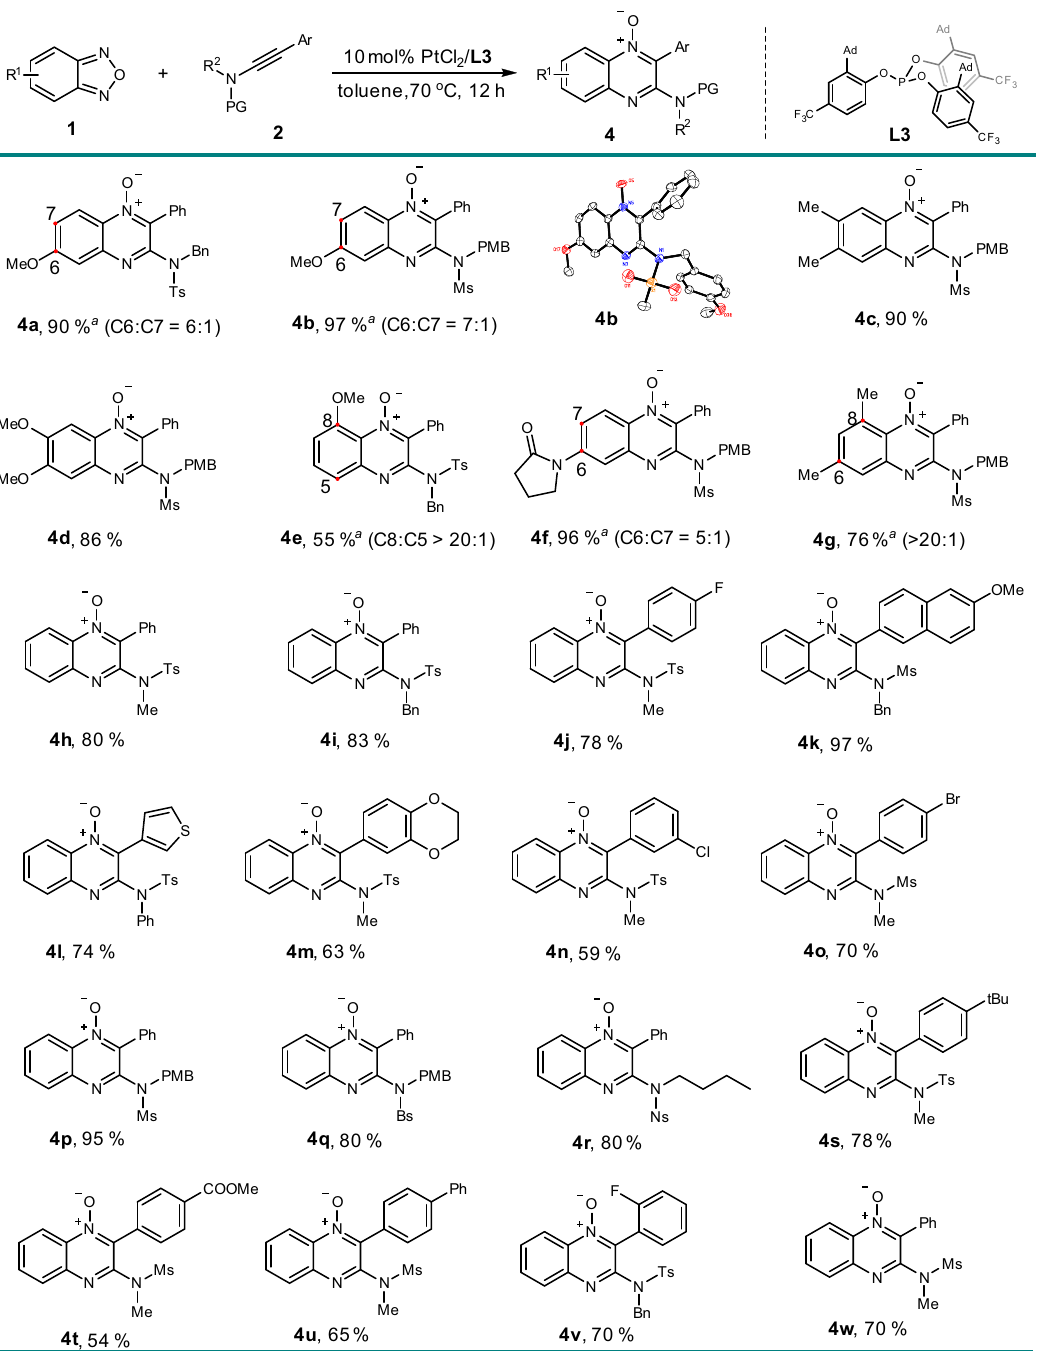
Fig. 4 Scope with respect to the Pt(II)-catalyzed annulations. Reaction conditions: 1 (0.2 mmol), 2 (0.1 mmol), 10 mol% PtCl 2 with 10 mol% L3 in 1 ml toluene at 70 °C for 12 h, unless otherwise noted. Isolated yields were listed. a Isomeric ratios were determined by 1 H NMR of the crude product mixture.PMB para -methoxybenzyl, Ms methanesulfonyl, Ns 4-nitrobenzenesulfonyl, Bs 4-bromobenzenesulfonyl.